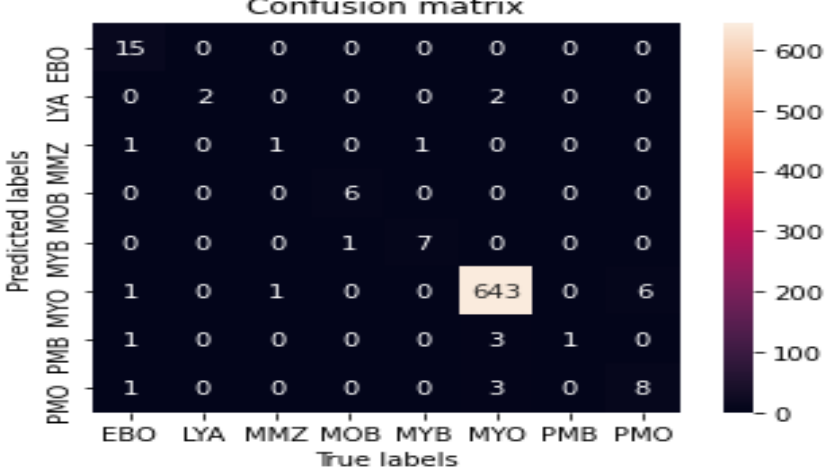
Figure 11. Confusion matrix for the atypical WBC multiclassification